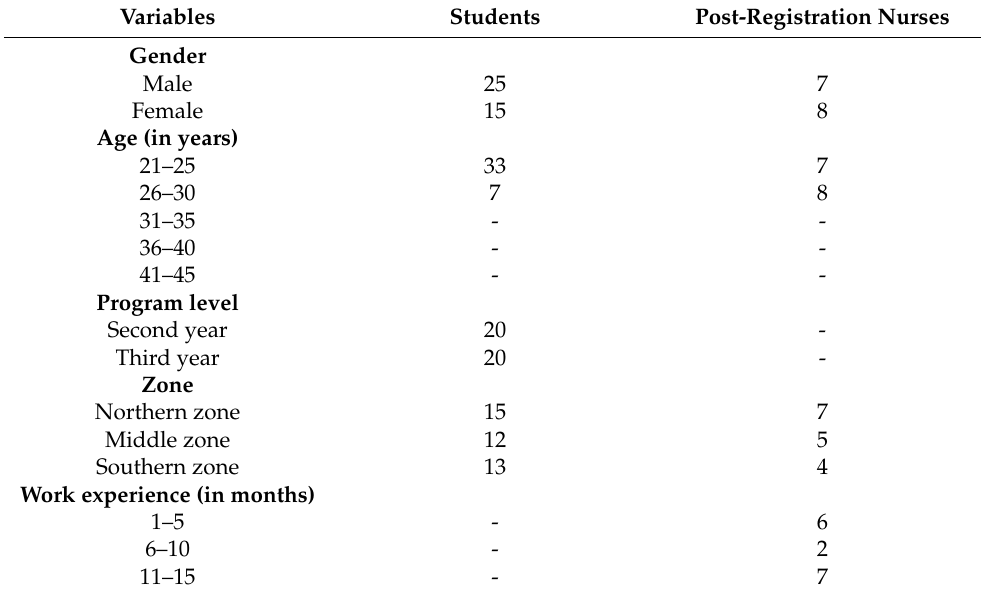
Table 2. Demographic characteristics of participants.